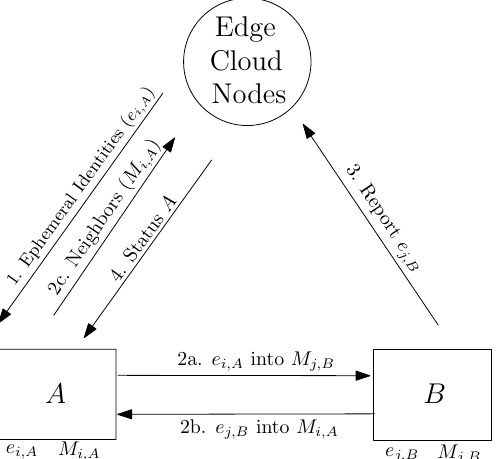
Figure 1. Use of edge cloud nodes to report faulty drones using (anonymous) ephemeral identifiers. Step 1 represents the broadcasting of ephemeral identities to drones A and B . In steps 2a and 2b, the drone A ’s data are stored in the memory of drone B . In Step 3, drone B reports a malfunction to the central service. In Step 4, the central service updates the neighboring drones (e.g., drone A , for